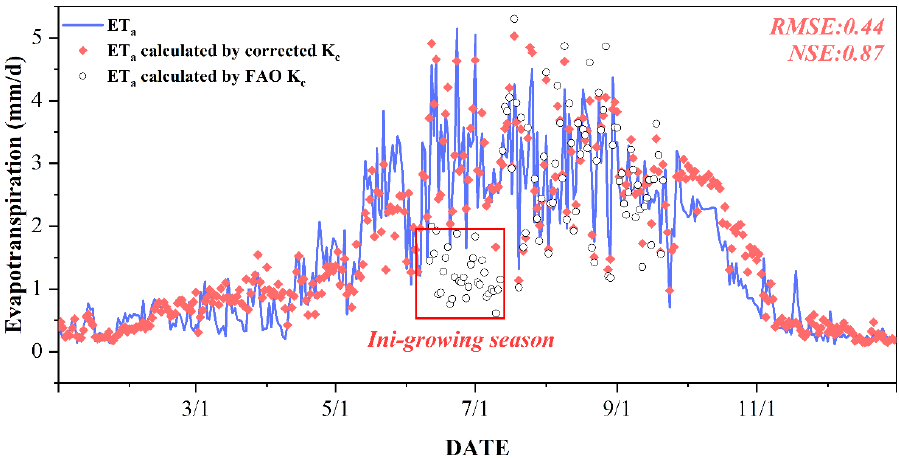
Figure 12. The corrected ET a (little red square) calculated by ET 0 compared with the ET a (blue line) measured by the Eddy covariance system and ET a (gray hollow circle) calculated by the FAO-recommended K c .